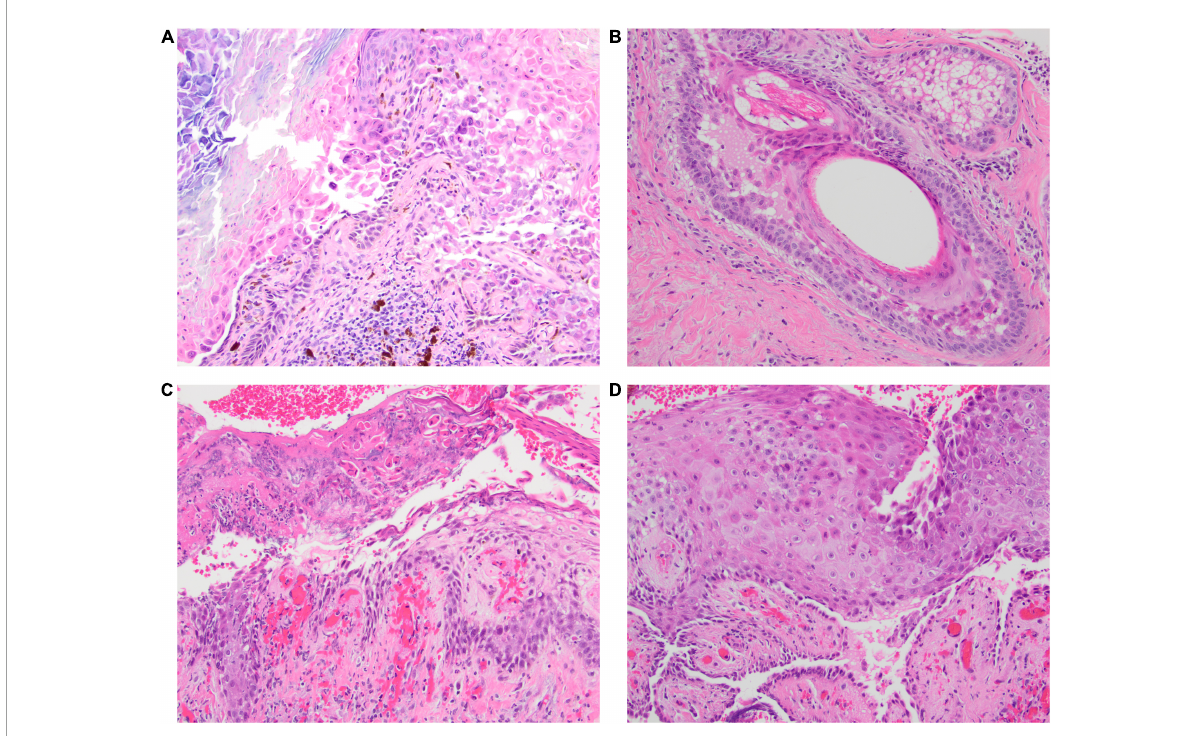
FIGURE2 (A–D) The initial biopsy taken from the scalp in Case 1 was interpreted on H&E (40x) to be consistent with Darier disease since the biopsy demonstrated acantholysis with prominent superficial dyskeratosis. Subsequent biopsy with direct immunofluorescence testing confirmed pemphigus vulgaris, without histologic evidence of pemphigus